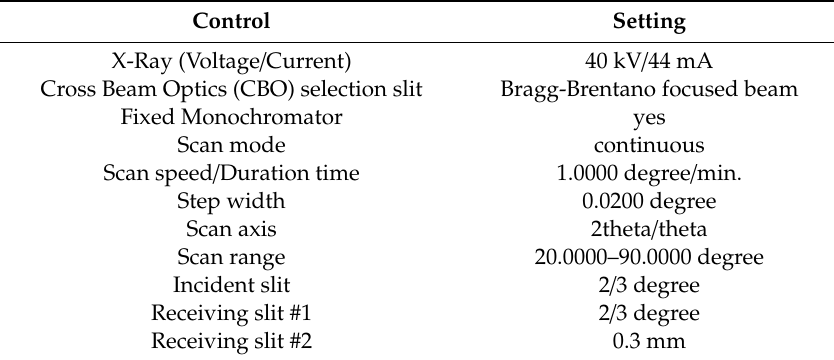
Table 1. Measurement conditions for X-ray di ff raction using